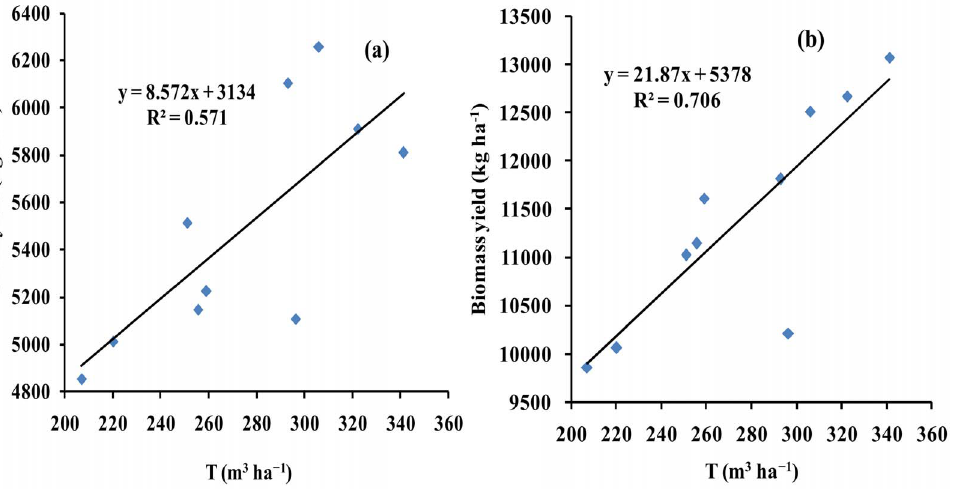
Figure 7. Relationships between the measured grain yield (GY), biomass yield (BY) and transpiration (T) in winter wheat. Note: (a) x represents transpiration, y represents the measured GY. The intercept represents the relative estimation error between transpiration and the measured GY. The slope represents the estimation consistency between transpiration and the measured GY. (b) x represents transpiration, y represents the measured BY. The intercept represents the relative estimation error between transpiration and the measured BY. The slope represents the estimation consistency between transpiration and the measured BY.